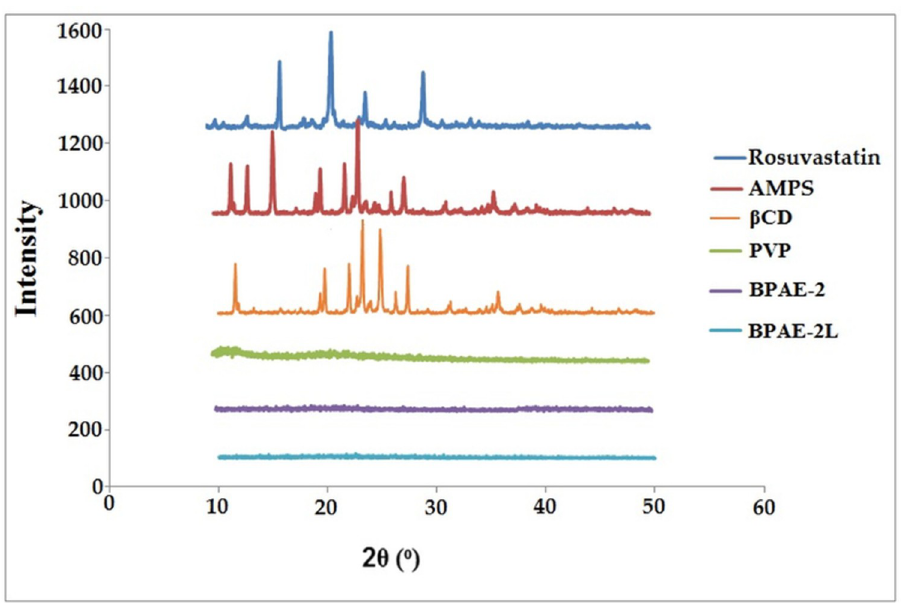
Fig 4. PXRD of Rosuvastatin, β CD, PVP, AMPS, unloaded (PBCD-2) and loaded (PBCD-2L) nanogels showing crystalline nature of components and amorphous nature of